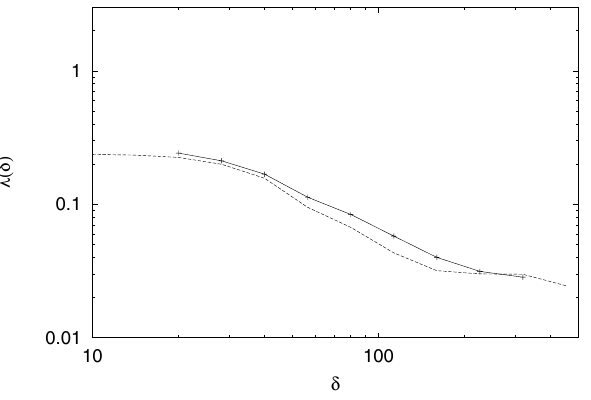
Fig. 5. Lagrangian Structure Function for data (continuous line) and model (dashed line) trajectories. δ is in km and ν(δ)/δ is in day − 1 . The experimental LSF is computed over all the pairs of drifters; the LSF from the model is averaged over 10 4